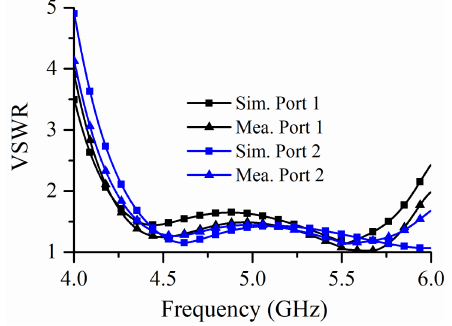
Figure 6. Simulated and measured